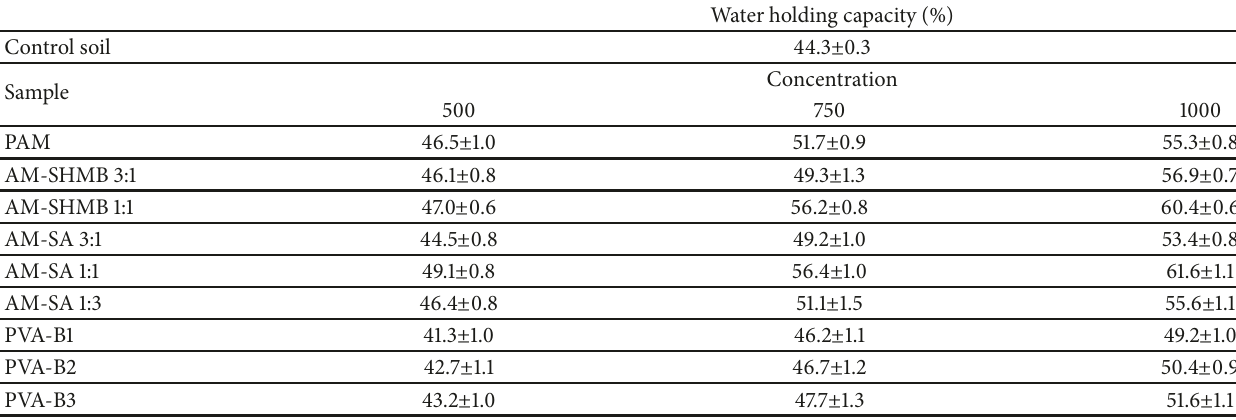
Table 1: WHC of the tested hydrogels. Concentrations of lyophilized hydrogels 500, 750, and 1.000 are expressed in mg per kg of soil dry